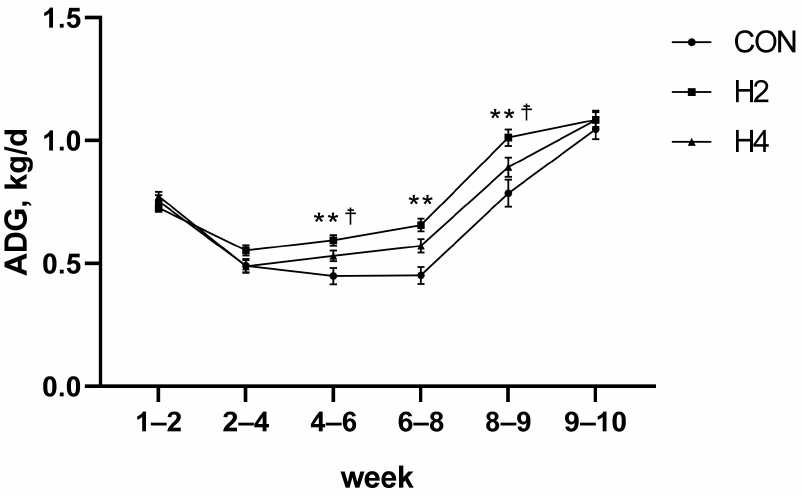
Figure 2. ADG for Holstein female calves fed a basic diet without (CON: solid circles; n = 70) or with hay inclusion from the second (H2; Solid squares; n = 70) or fourth (H4; Solid triangles; n = 70) week of age. Differences between CON and hay groups are represented by an asterisk ( p < 0.05, denoted by **). Differences between H2 and H4 are represented by a cross ( p < 0.05, denoted by ☨ ).